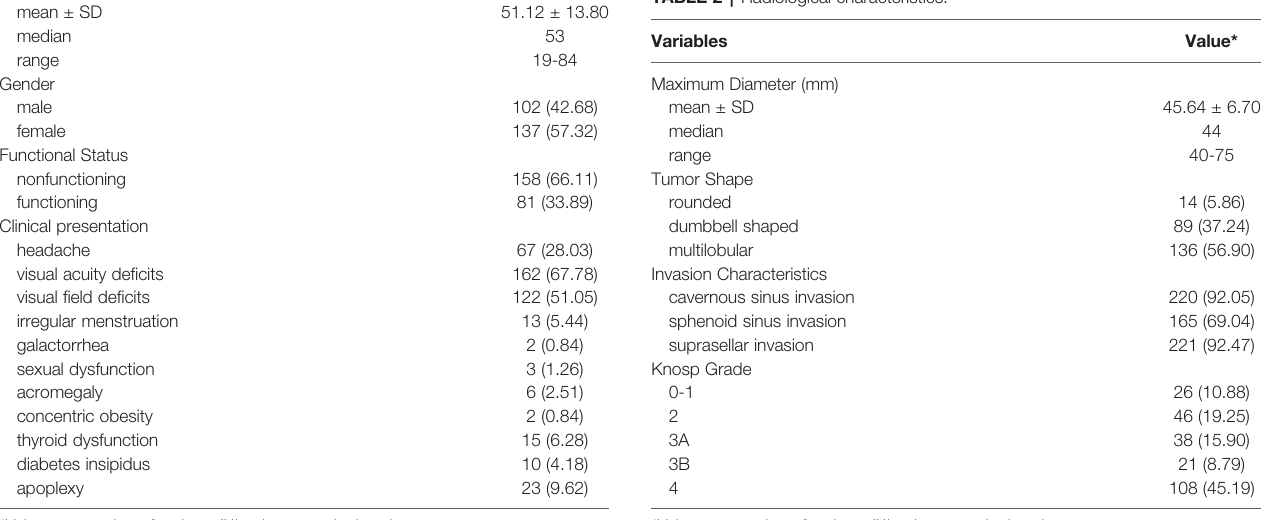
TABLE 2 | Radiological